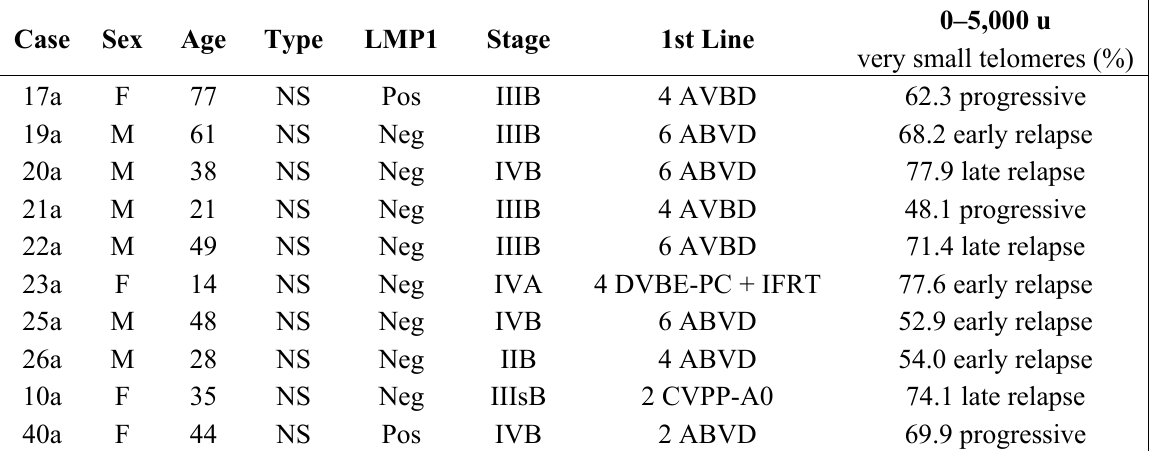
Table 2. Clinical data and percentage of very small telomeres of mononuclear Hodgkin cells at diagnosis (mean 65.6%) in patients with progressive or relapsing